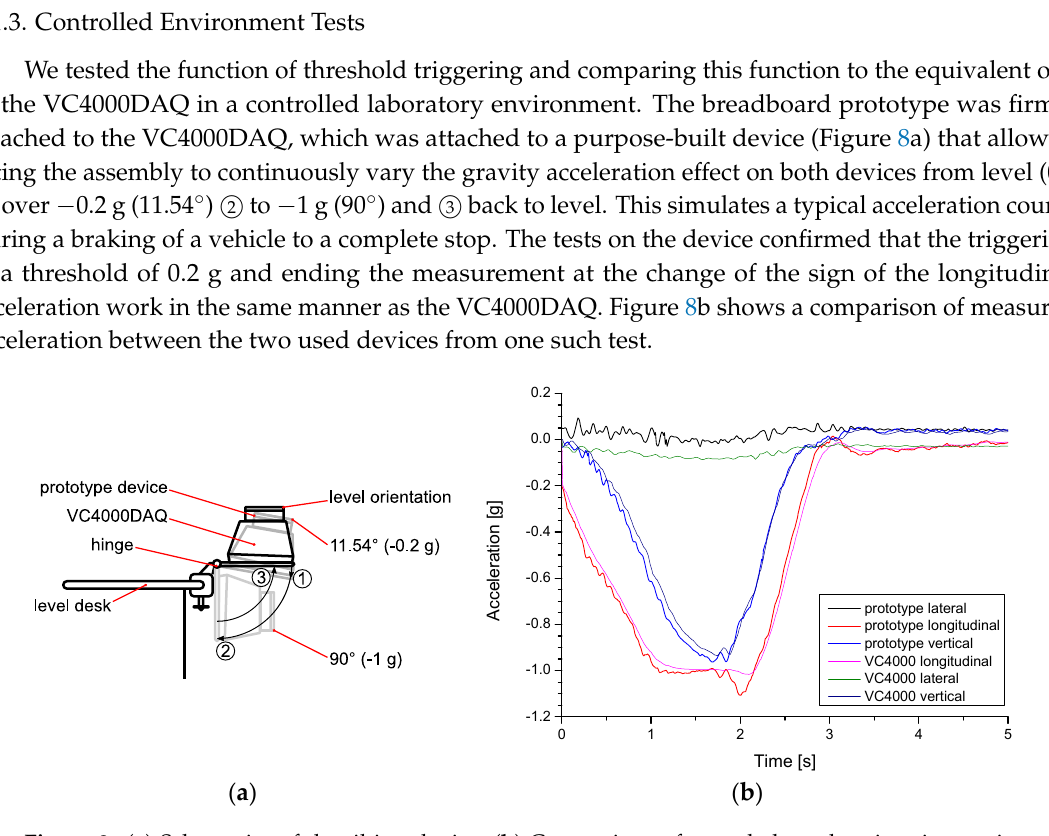
Table 5. Statistical comparison of measured data between the prototype device and the VC4000DAQ. Test #